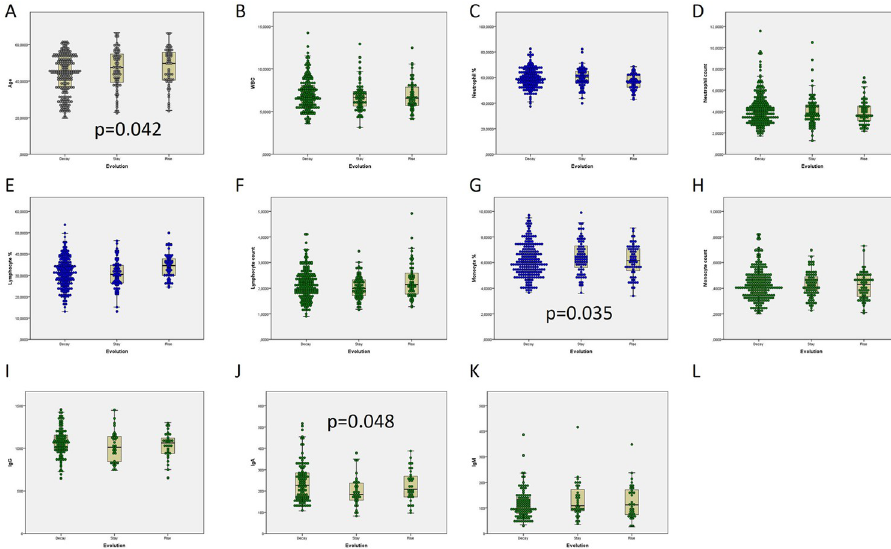
Fig 5. Analysis of age, haemogram and immunoglobulins in donations. Comparison of age, haemogram, and total, non-specific immunoglobulins in donations from donors whose total immunoglobulins recognizing anti SARS-CoV-2 N protein will decline, remain the same or rise, as regarding their second donation. Decay: OD under 90% of the previous one; stay: OD +/-10% of the previous one; rise: OD over 110% of the previous